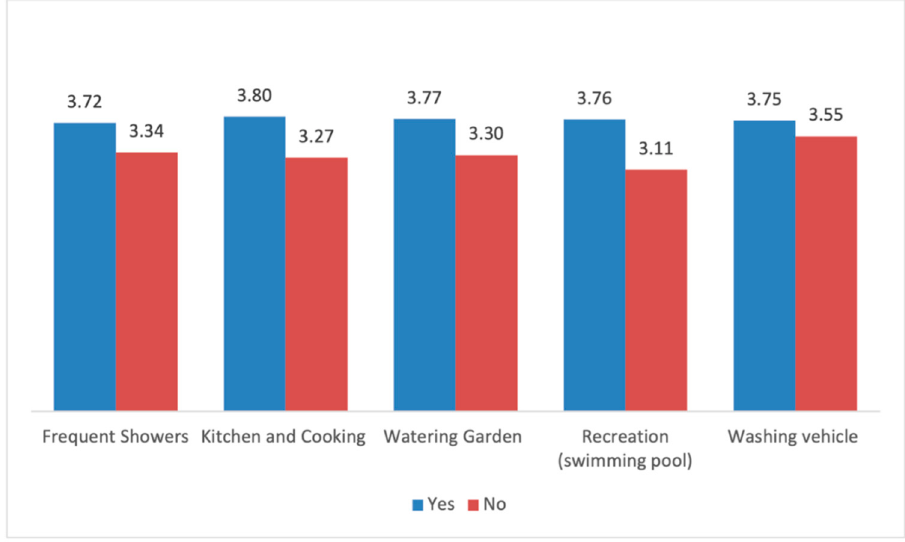
Figure 5. Water consumption based on household activities.